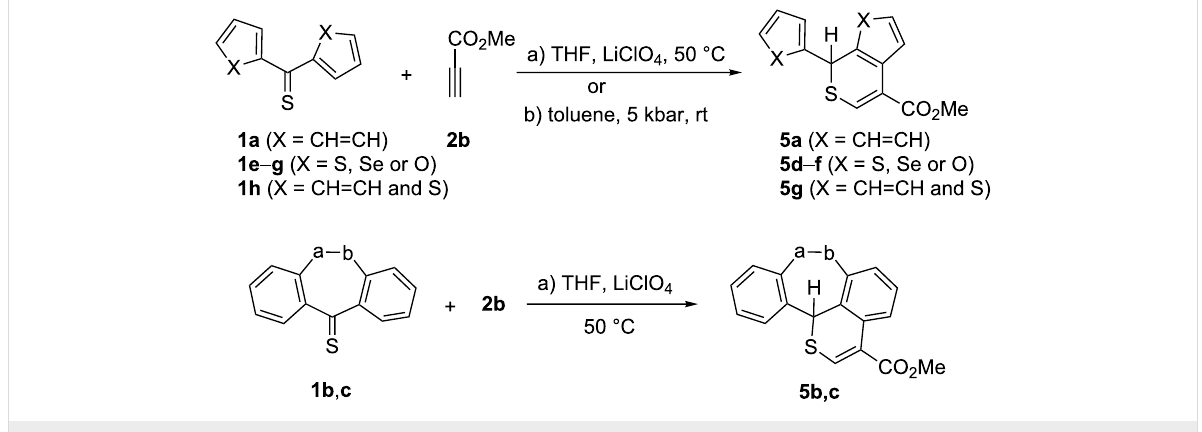
Scheme 3: Reactions of aryl/hetaryl thioketones with methyl propiolate (Table 1).